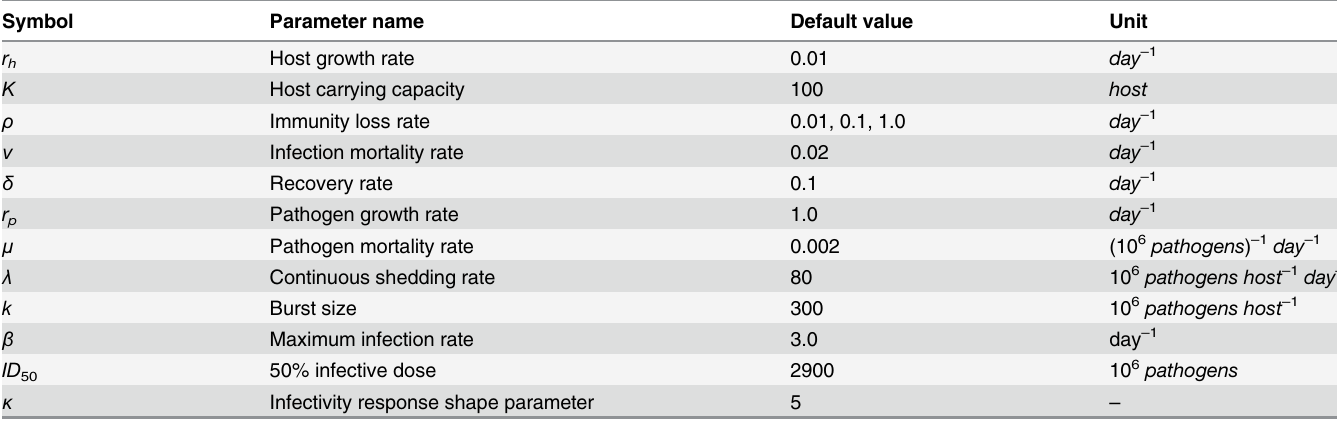
Table 1. Model parameters and values used in